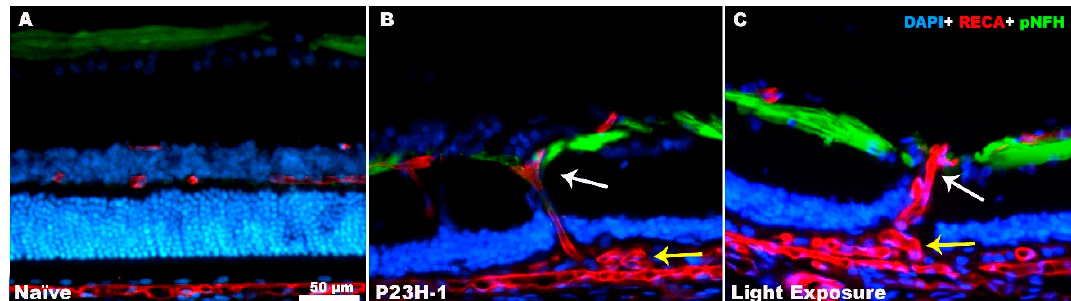
Figure 3. Retinal remodeling causes axonal and vascular changes. Microphotographs of retinal cross sections from a naïve SD rat showing a normal retinal structure ( A ), the retinal structure of a P23H-1 rat ( B ) and the retinal structure of a light-exposed SD rat ( C ) after the complete loss of photoreceptors. Retinal ganglion cell (RGC) axons appear in green labelled with anti-neurofilament antibodies (pNFH), the blood vessels in red labelled with anti-rat endothelial cell antigen (RECA) and the nuclei in blue labelled with DAPI. In B and C, blood vessels are running vertically in the retina (white arrow) because they are dragged to the subretinal vascular complexes that appear between the RPE and Bruch’s membrane (yellow arrow) with the inner retinal vascular plexus. RGC axons are displaced by the vessels, which will eventually cause RGC death.